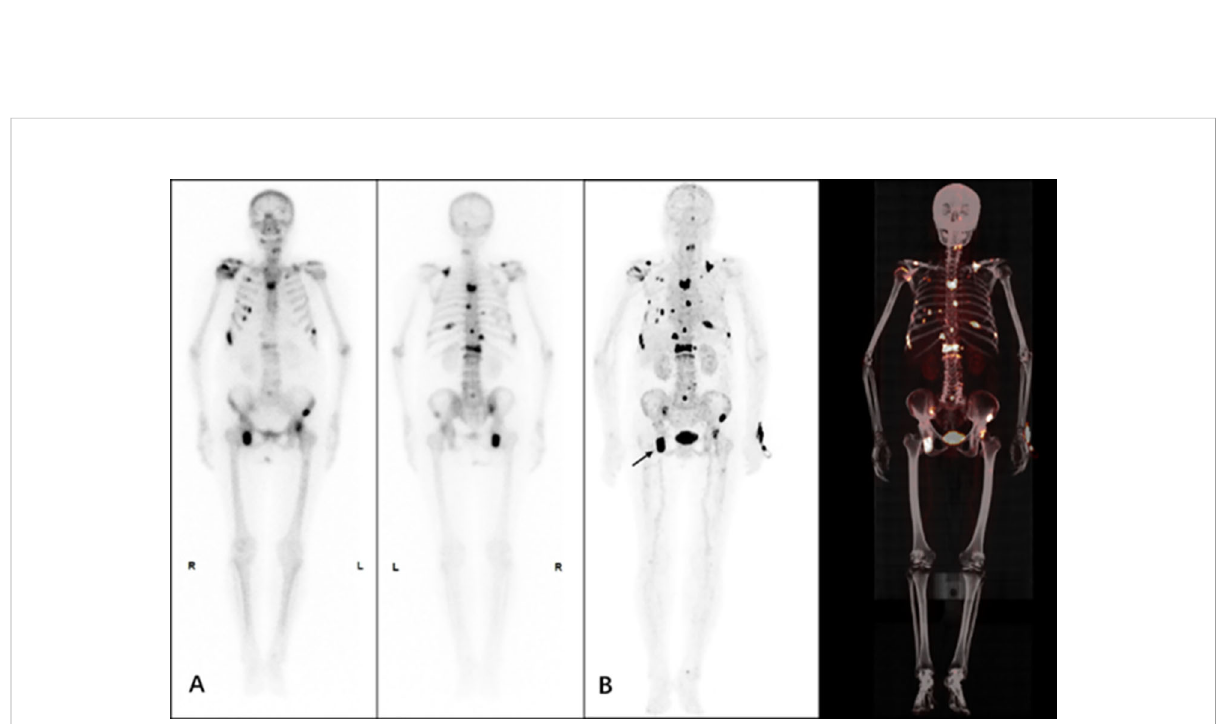
FIGURE 8 A 60-year-old female patient, who underwent surgery for left breast cancer 3 years previously who had recent generalized skeletal pain. The patient underwent 99m Tc-MDP (A) and 68 Ga-DOTA-IBA (B) imaging. From the MIP image multiple bone lesions were detected throughout the body with multiple foci of abnormal developer concentrations and a SUVmax of approximately 10.2 for the lesion, T/NT 9.1